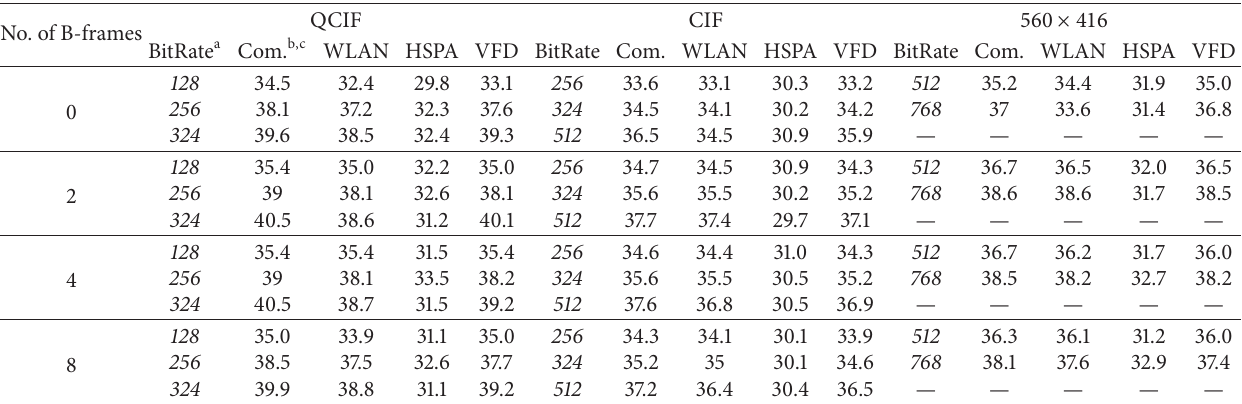
a Bitrate in kbps, b all PSNR measurements in dB, c compressed